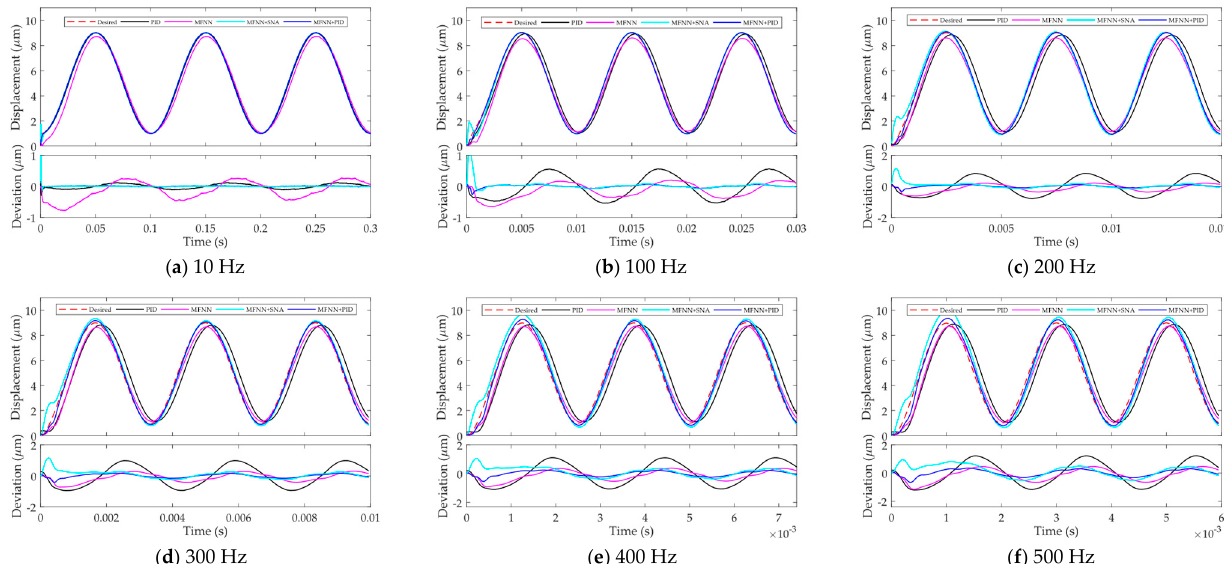
Figure 8. Comparison of the tracking performance across a wide frequency range. ( a ) 10 Hz; ( b ) 100 Hz; ( c ) 200 Hz; ( d ) 300 Hz; ( e ) 400 Hz; ( f ) 500 Hz.